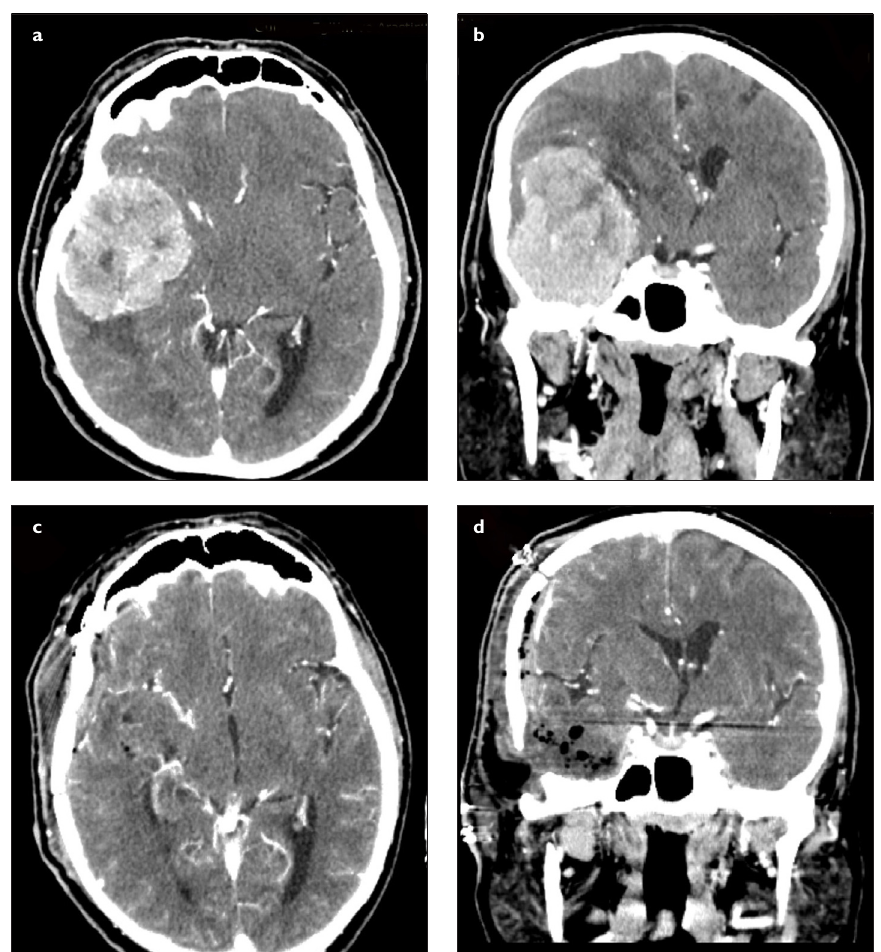
Figure 2. a-d. (a) Preoperative axial and (b) coronal CT scans (with contrast) of a patient with giant right temporal fossa meningioma originating from the skull base dura mater. There was a significant midline shift and brain edema. The patient underwent gross total resection using right temporal craniotomy. (c) Postoperative axial and (d) coronal CT scans (with contrast) confirmed gross total resection. The